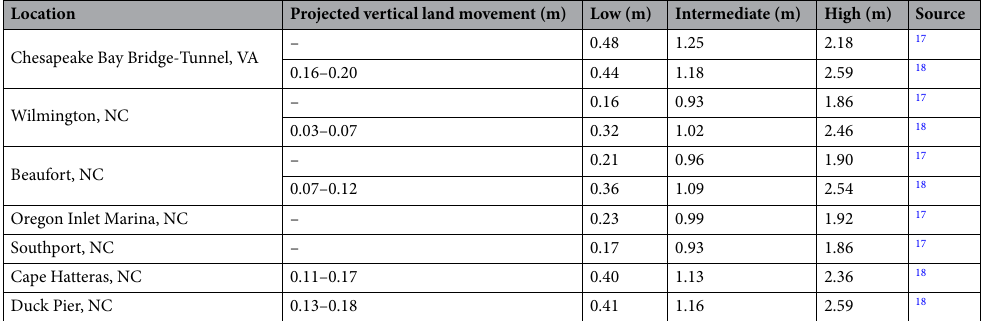
Table 1. Sea level rise projections for 2100. Sweet et al., 2017 18 consider vertical land movement (VLM) along with changes in global circulation patterns and the Earth’s crust, corresponding to 6 global GMSL scenarios (0.3–2.5 m). These projections rely on GPS observing stations and discretized GMSL projections in line with a range of RCPs. Hall et al., 2016 17 rely on similar IPCC projections but also incorporate relative SLR rates derived from historical GPS records and land surveys.